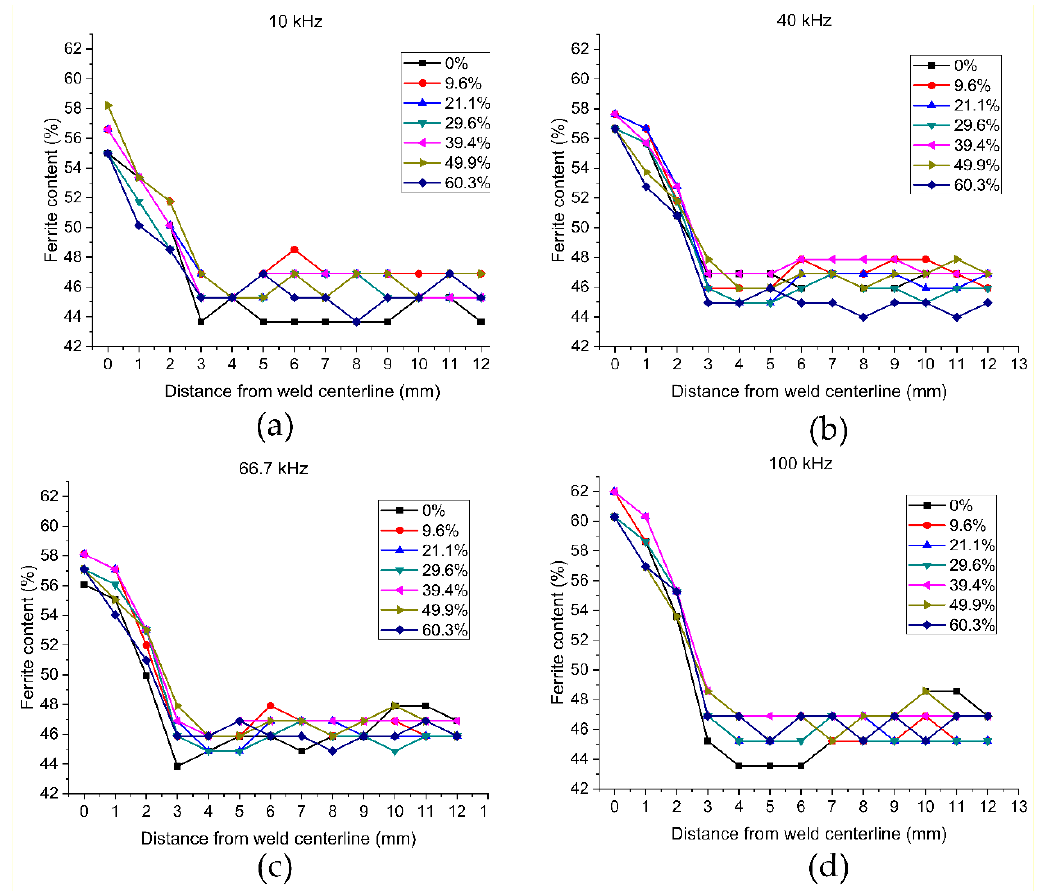
Figure 12 Evolution of the volume fraction of ferrite with respect to the distance from the weld centerline.